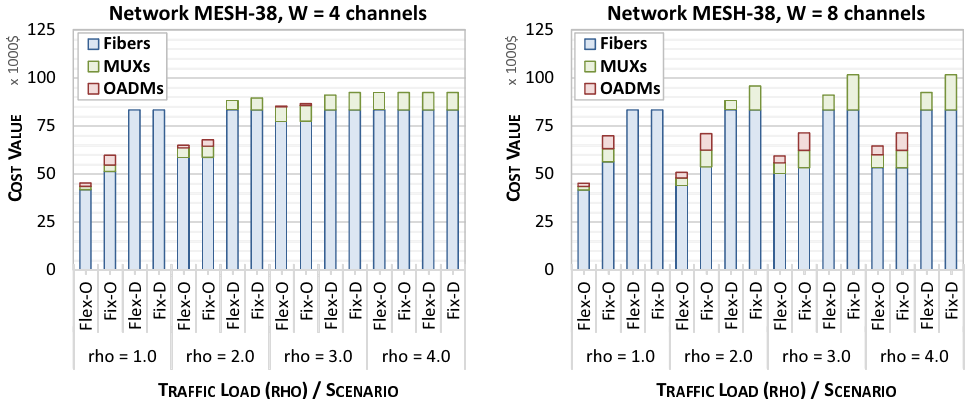
Figure 9. Comparison of particular cost elements in different network deployment scenarios assuming different traffic loads ( ρ ) and WDM system capacities ( W ) in network MESH-38.